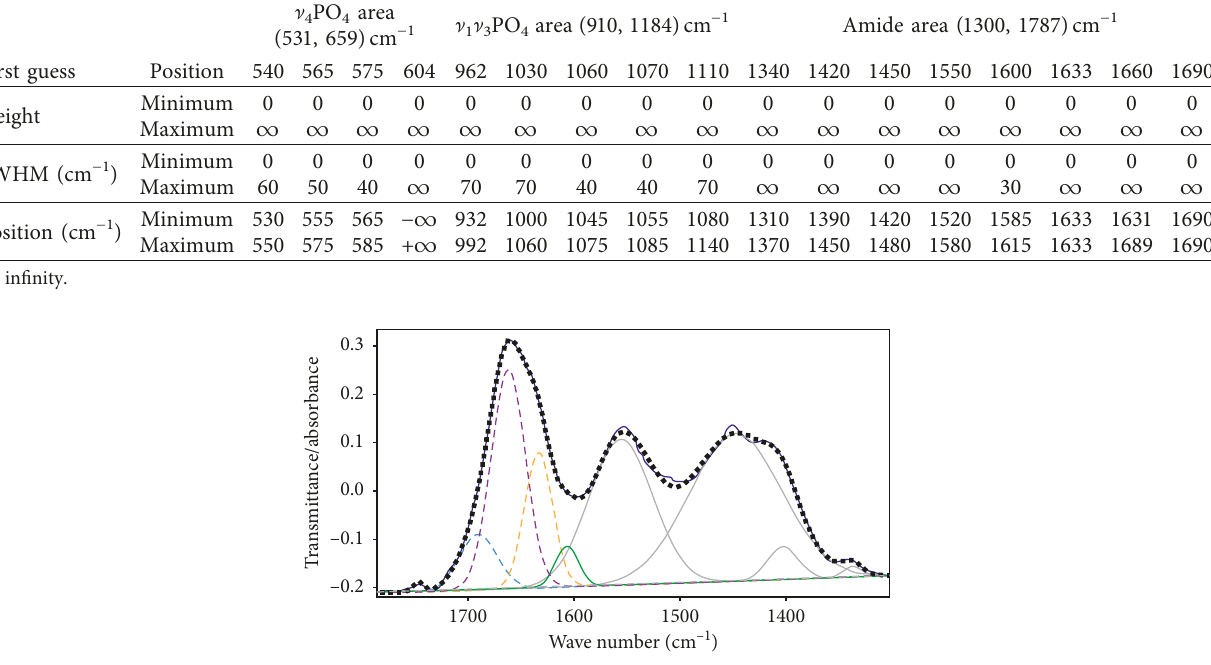
Figure 5: Original spectrum in the amide area (dark blue line) recovered by the Gaussian sum fitting (dotted-black line) and the 8 individual peaks beneath (dashed and full lines) + 1 peak for the MMA (1730cm − 1 ). The two peaks directly used to compute the Collagen Maturity parameter are the 1660 cm − 1 peak (dashed-purple line) and the 1690cm − 1 peak (dashed-blue one).